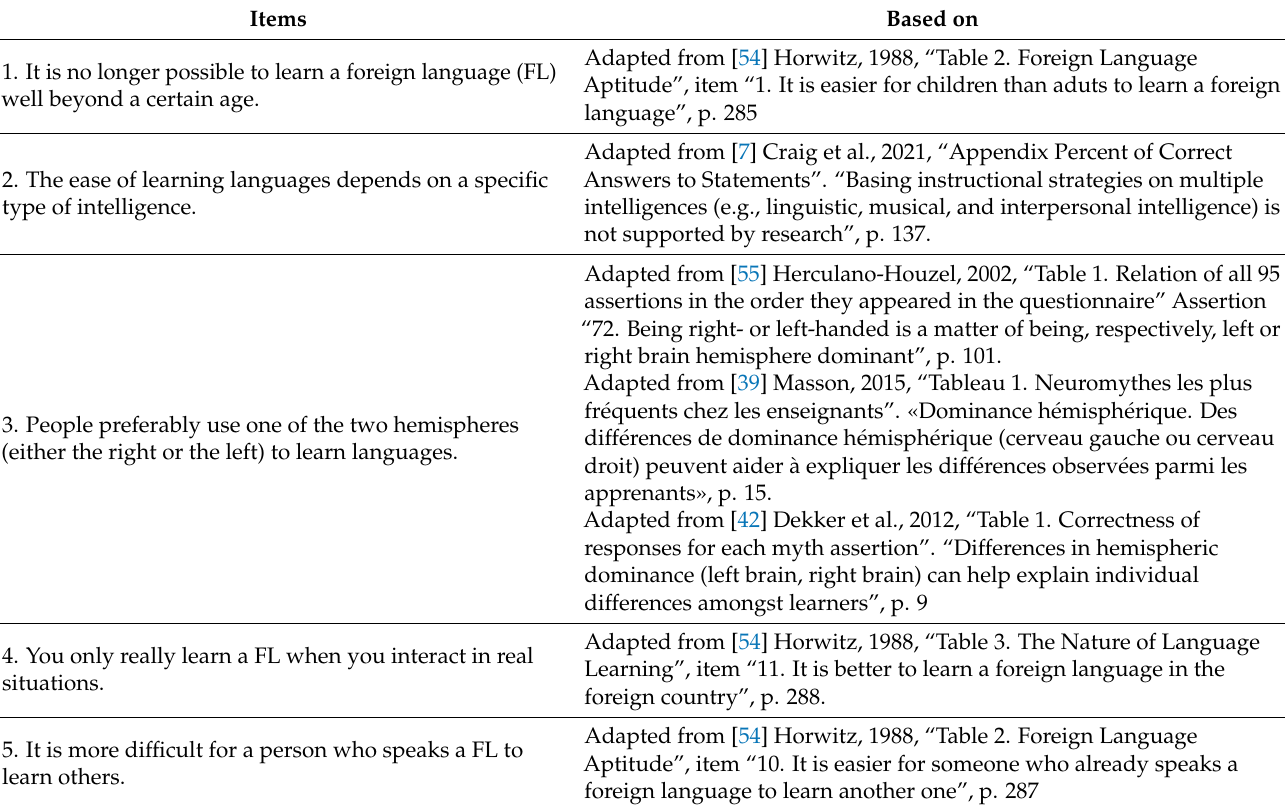
Table A2. Justification for the Chosen Items and Adaptation Based on